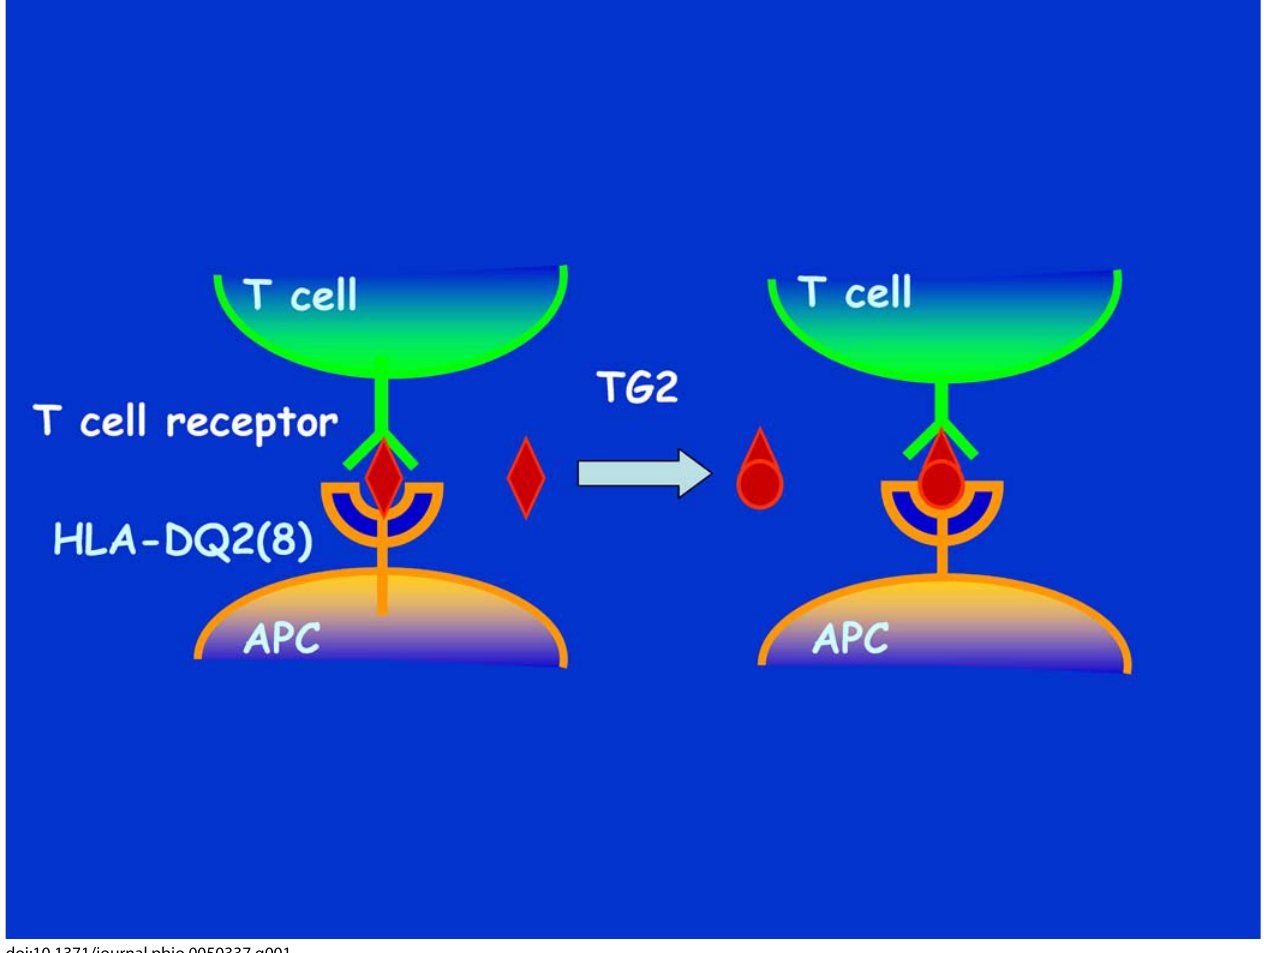
Figure 1. HLA-DQ2 and HLA-DQ8 Are Expressed on So-Called Antigen-Presenting Cells The function of antigen-presenting cells (APCs) is to bind peptides derived from pathogens and “present” these to the T cells of the immune system. T cells detect such HLA–peptide complexes through their T cell receptors. In celiac disease, T cells respond to gluten peptides bound to HLA-DQ2 or HLA-DQ8. Gluten-derived peptides (red diamond) bind only with low affinity to HLA-DQ2 and HLA-DQ8, but TG2 can modify such peptides, which turns them into high-affinity binders. Consequently, the HLA–gluten peptide complexes are more stable, which facilitates and enhances T cell responses to such